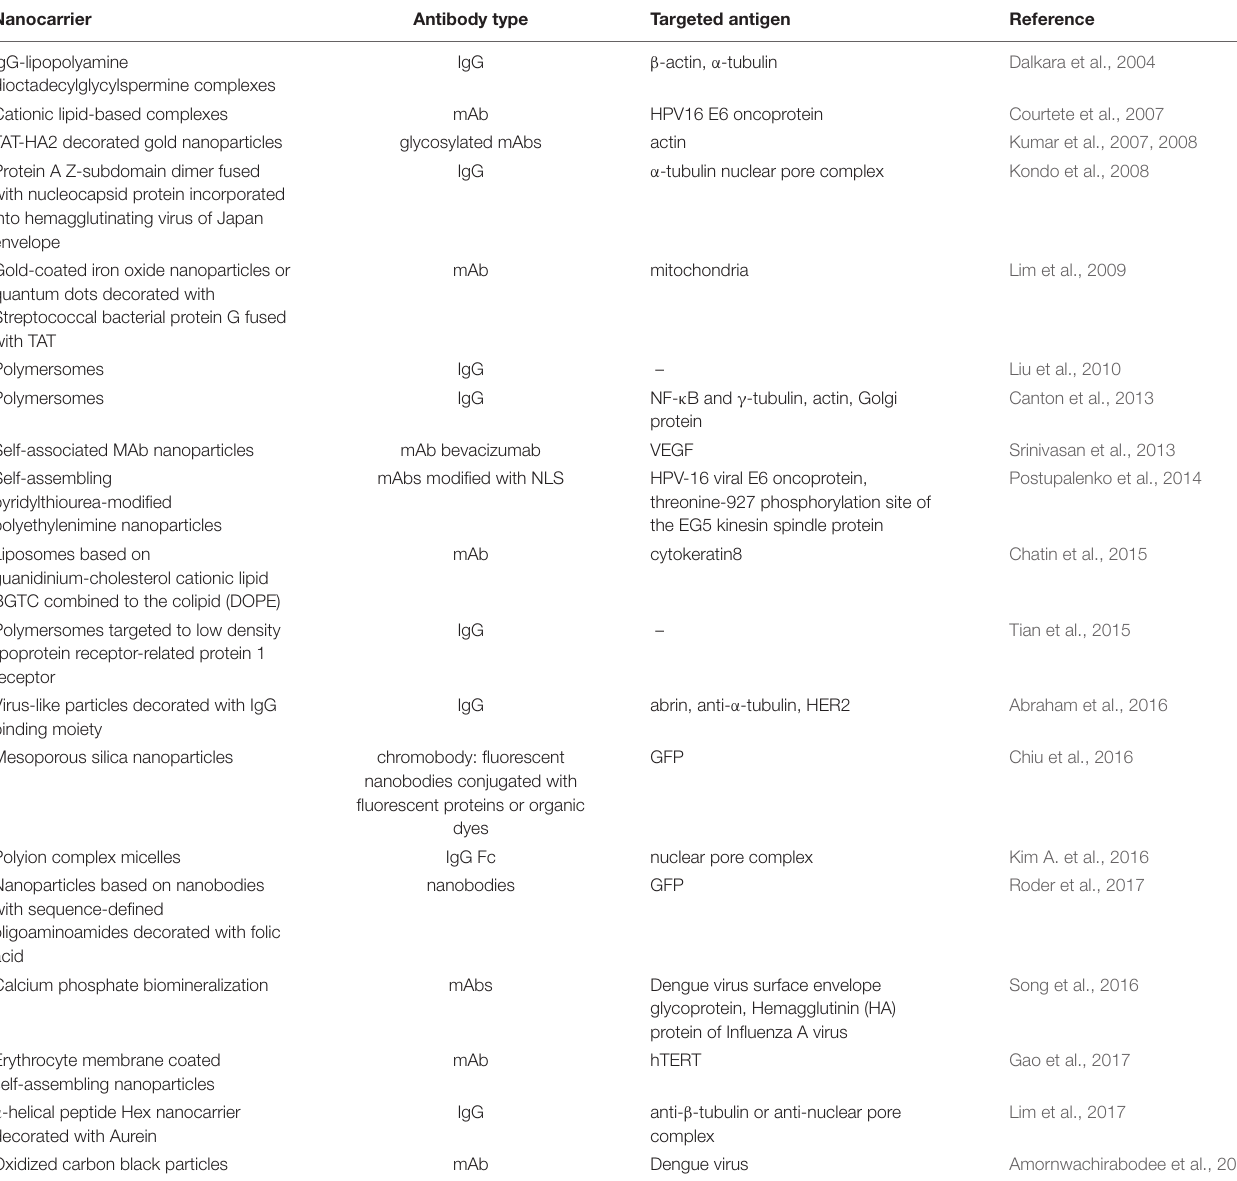
TABLE 3 | Examples of intracellular delivery of antibodies by